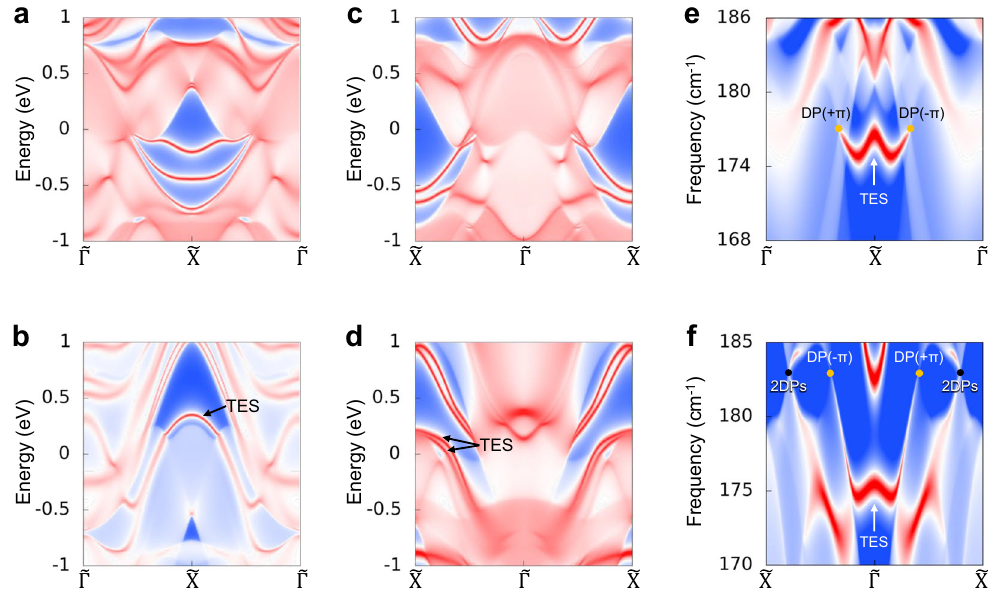
Fig. 5 Electronic and phononic topology in 2D MX . The zigzag electronic spectra of a ZrCl, b MoCl, c ZrF and d MoF. Here, the nontrivial topological edge states (TESs) in between α and β bands are labeled. The phononic spectra near DPs of e ZrCl along zigzag edge and f MoCl along zigzag edge. Here, the bulk projected DPs are marked with dots. The golden ones exhibit nontrivial Berry phases of ± π , while the black ones are projected from two DPs, having trivial Berry phases of ±2 π . Notice the marked TESs have w-shape dispersions and connect to the nontrivial projected